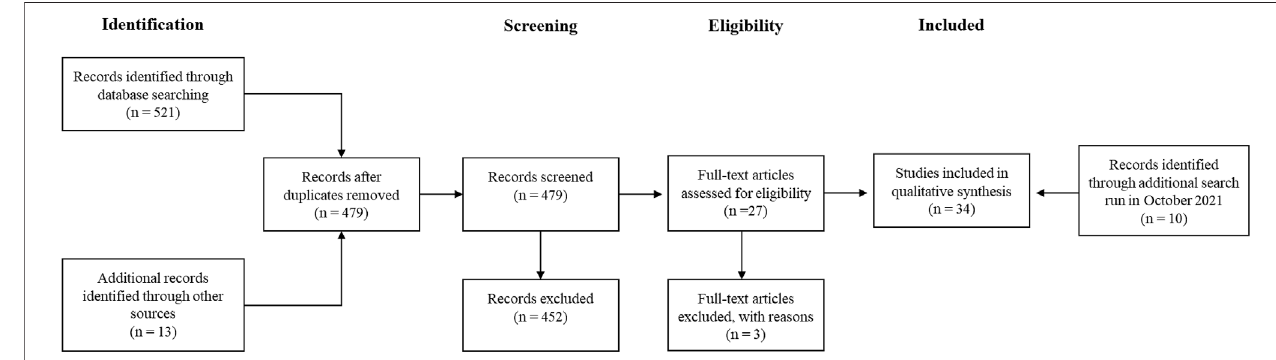
FIGURE 1 | Study selection process following PRISMA